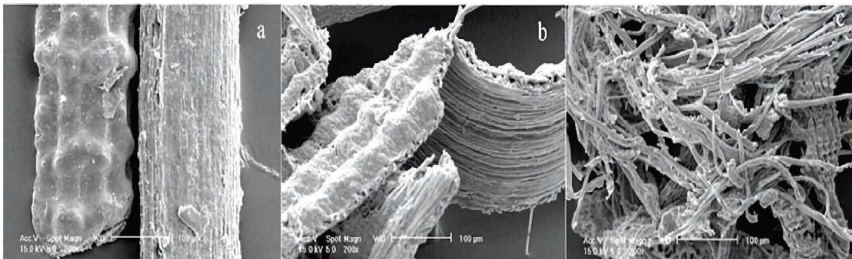
Figure 8: SEM imaging of (a) untreated rice husk fbers with a smooth surface; (b) alkali treated rice husk fbers with a rougher structure due to the removal of lignin, hemicellulose, pectin, and other noncellulosic materials; (c) bleached rice husk fbers with the smallest particle size in comparison to the other treatments, providing the diameter [112]. Copyright and permission from